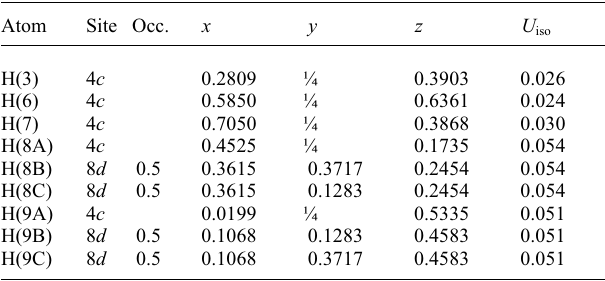
Table 2. Atomic coordinates and displacement parameters (in Å 2 )